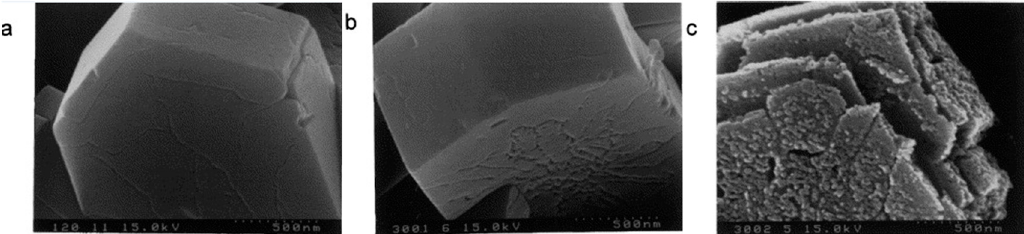
Figure 4. SEM images of alkaline-treated ZSM-5. Treatment was carried out in a 0.1 M NaOH solution at 338 K for ( a ) 120 min, ( b ) 300 min, and ( c ) in a 0.2 M solution at 353 K for 300 min. (Adapted from [86]. Copyright 2001 Elsevier).